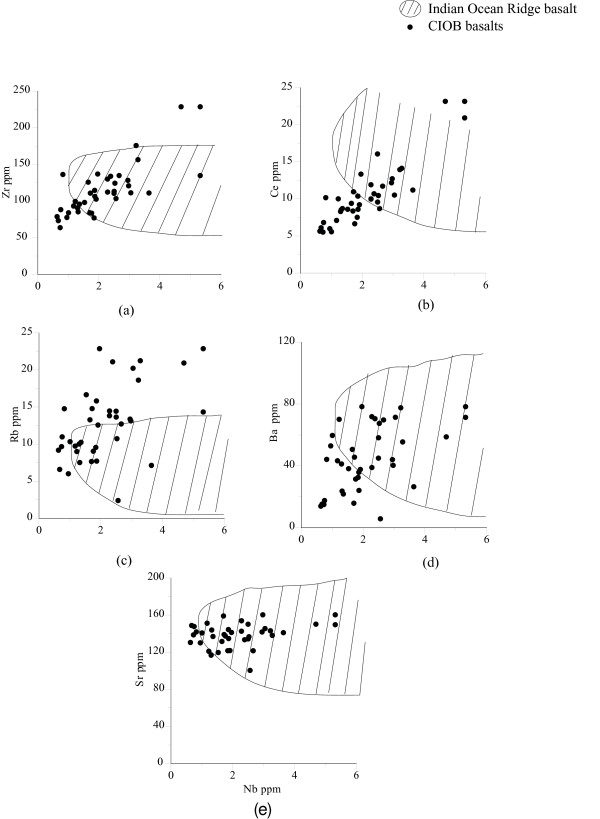
The incompatible elements Zr, Ce, Rb, Ba and Sr show a variable distribution with Nb of the CIOB basalts. The hatched area represents IOR basalts (data from PETDB http://www.petdb.org/). Note that Zr, Ce and Ba show a relative depletion whereas Rb shows relative enrichment than the IOR basalts for a given Nb concentration. Sr shows a very close association with the IOR basalts.